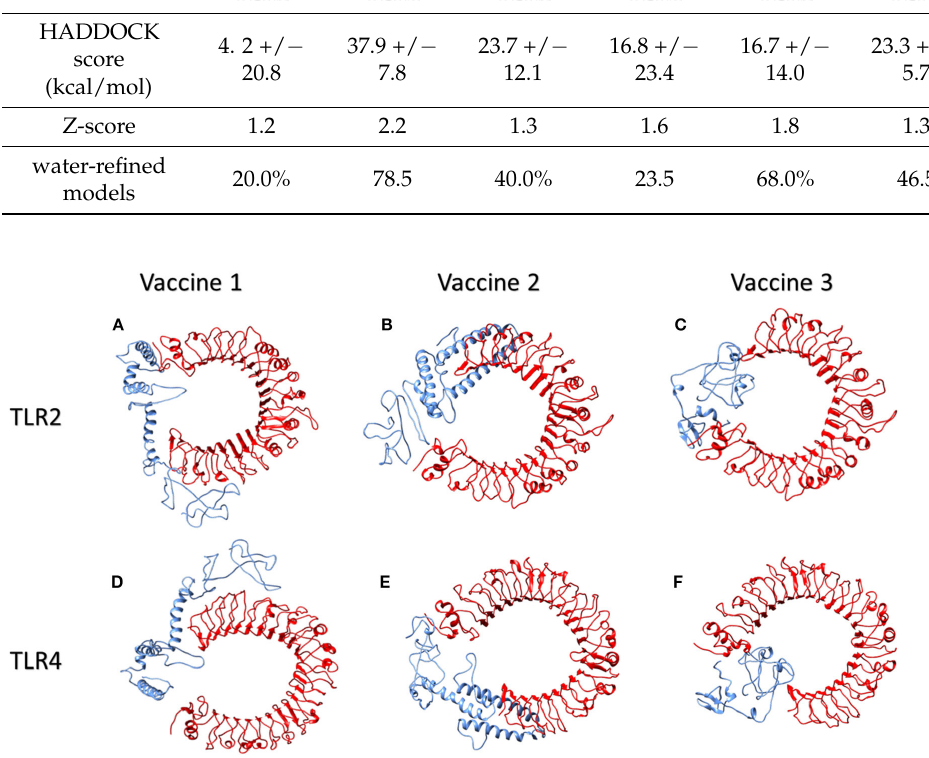
Table 3. Statics interaction parameters of TLR2 and TLR4 with vaccines 1, 2, and 3. Parameter